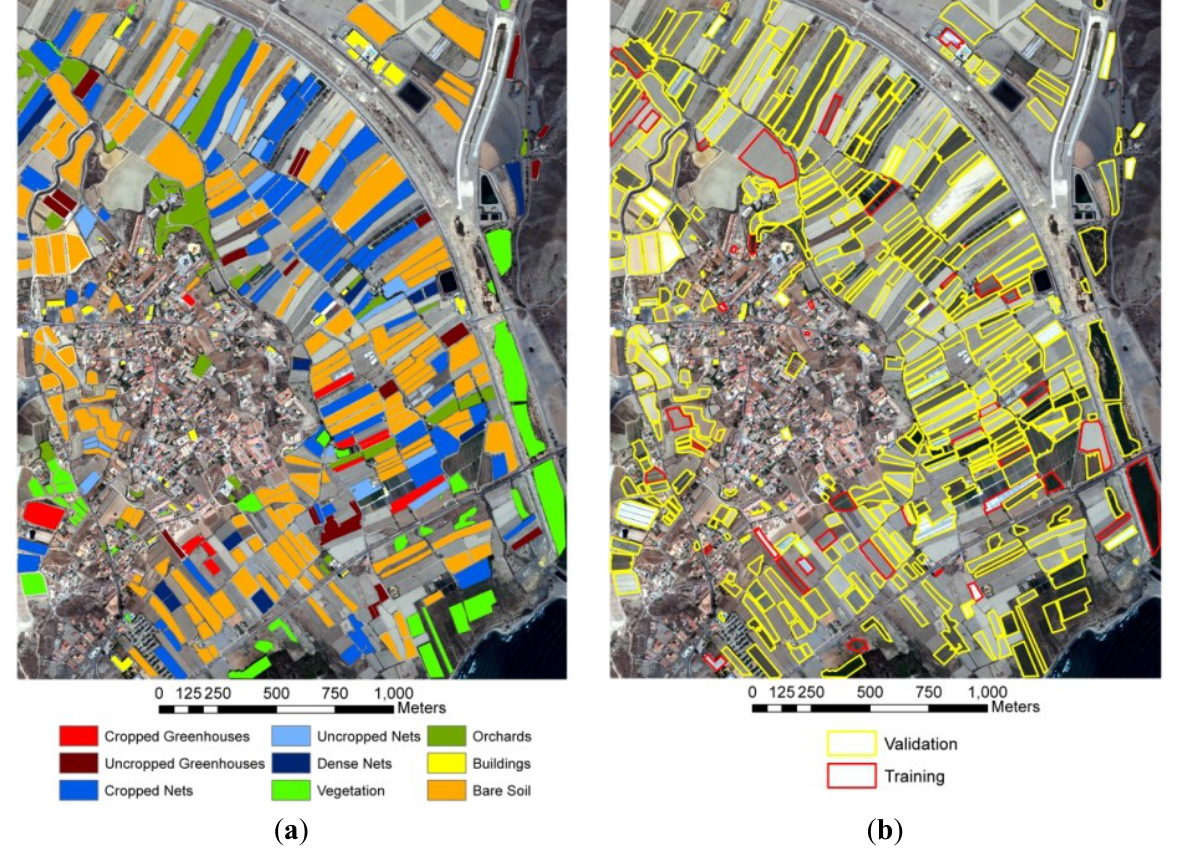
Figure 4. Location of the 406 objects digitized over the PNOA’s orthoimage. ( a ) Classes assigned to each object; ( b ) training and validation sets.